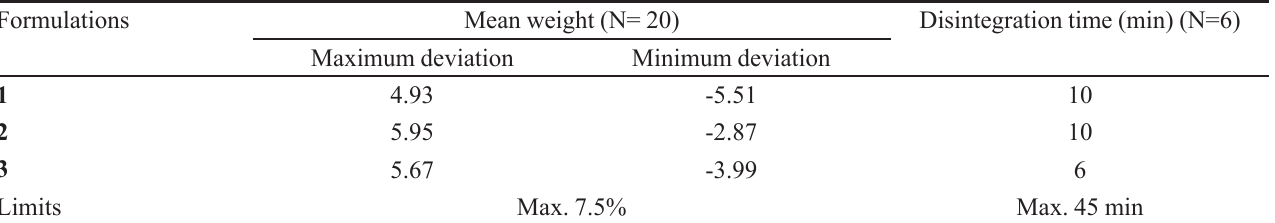
TABLE V – Physicochemical analyses of different formulations of OXC capsules Formulations